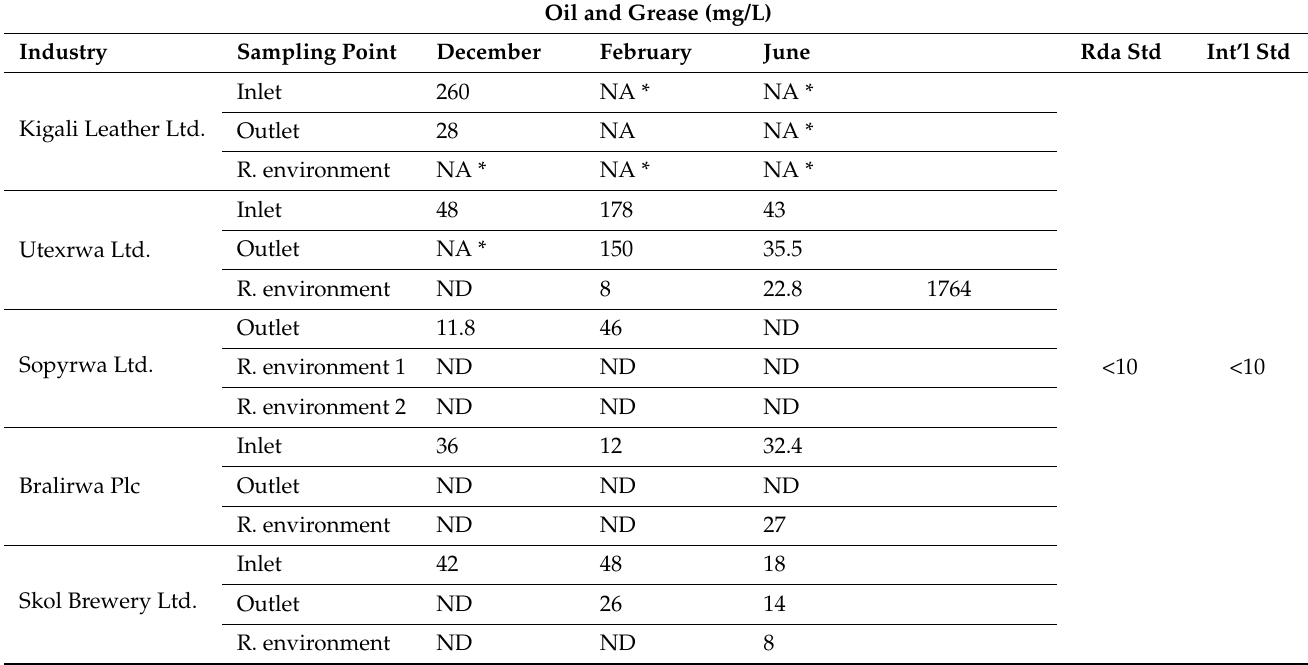
Table 5. Oil and grease results for the selected industries. Oil and Grease (mg/L)